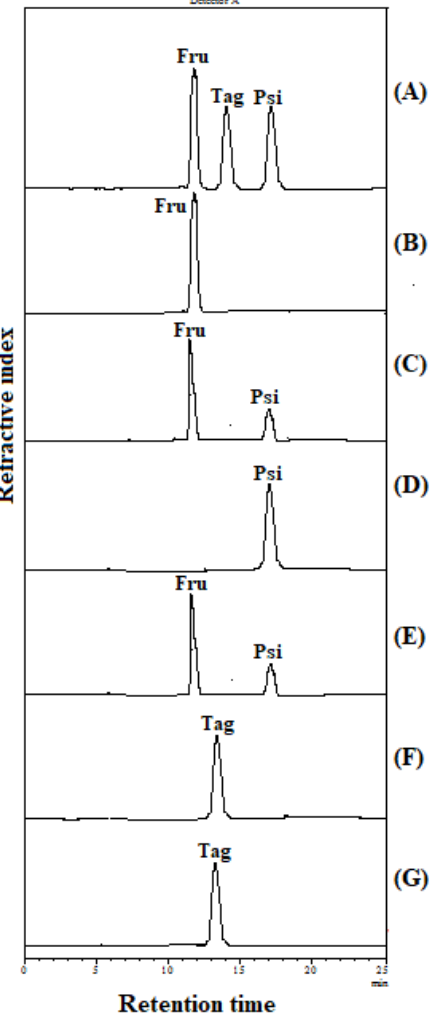
Figure 2. HPLC analysis profiles of IfDPEase (5 µ M) on 10 mg/mL of D-fructose, D-psicose, and D-tagatose with 1.0 mM Mn 2+ at 50 ◦ C and pH 7.5 (50 mM Tris-HCl buffer) for 5 min. ( A ) Standards, D-fructose, D-tagatose, and D-psicose; ( B , D , F ) each substrate with denatured enzyme ( C , E , G ); IfDPEase reaction to D-fructose, D-psicose, and D-tagatose, respectively. Most ketose 3 ‐ epimerases, including IfDPEase, prefer to catalyze D ‐ psicose over D ‐ fructose, possibly due to the formation of more hydrogen bonds between D ‐ psicose and the enzyme [11]. However, the epimerization reaction ratio between D ‐ fructose and D ‐ psicose for IfDPEase (0.70) was higher compared to those of most other 3 ‐ epimerase mem ‐ (cid:1) bers (0.33–0.66) except for the DFEase from R. sphaeroides (1.81), which prefers to catalyze D ‐ fructose over D ‐ psicose (Table 3). Table 3. Comparison of specific activity of ketose 3 ‐ epimerases from various microorganisms. Enzyme